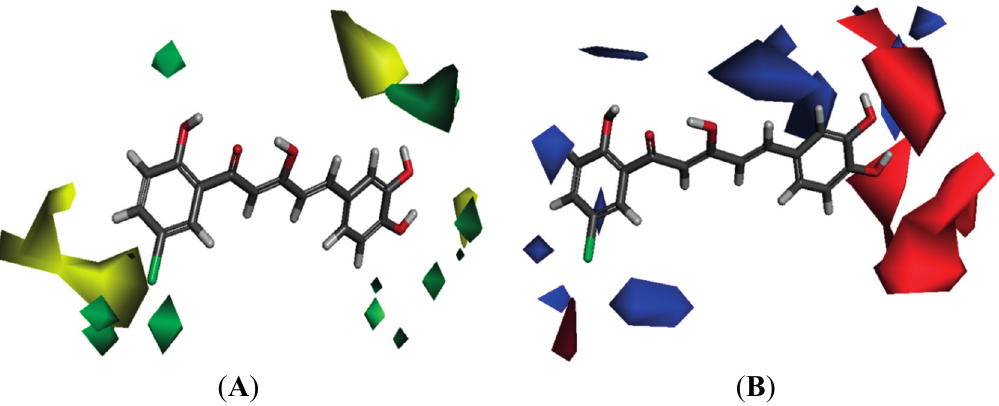
Figure 6. ( A ) Van der Waals contour maps generated by 3D-Quantitative structure activity relationship (QSAR) modeling. Green contours indicate the regions where bulky groups are favorable in enhancing activity, whereas yellow contours indicate regions where bulky groups are disfavorable and reduce activity. ( B ) Electrostatic contour maps generated by 3D-QSAR modeling. Blue contours indicate regions where electronegative groups are favorable in increasing activity, whereas red contours indicate regions where electropositive groups are favorable in improving activity. The most potent candidate, compound 88 was chosen as reference